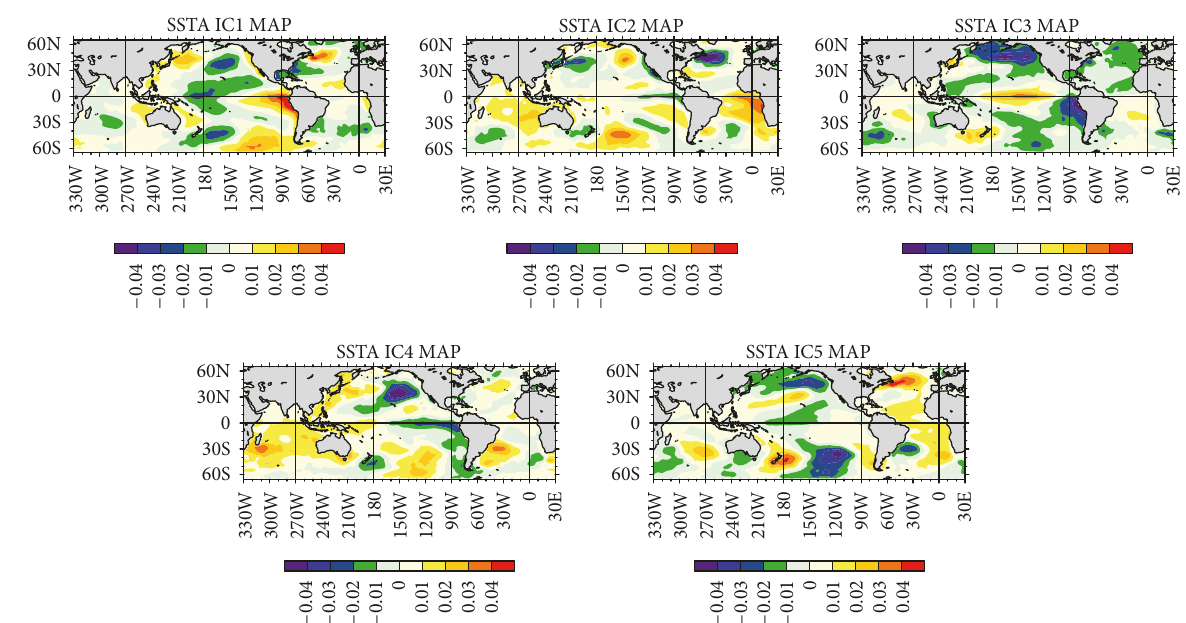
Figure 12: Spatially normalized loading maps of the 5 sorted